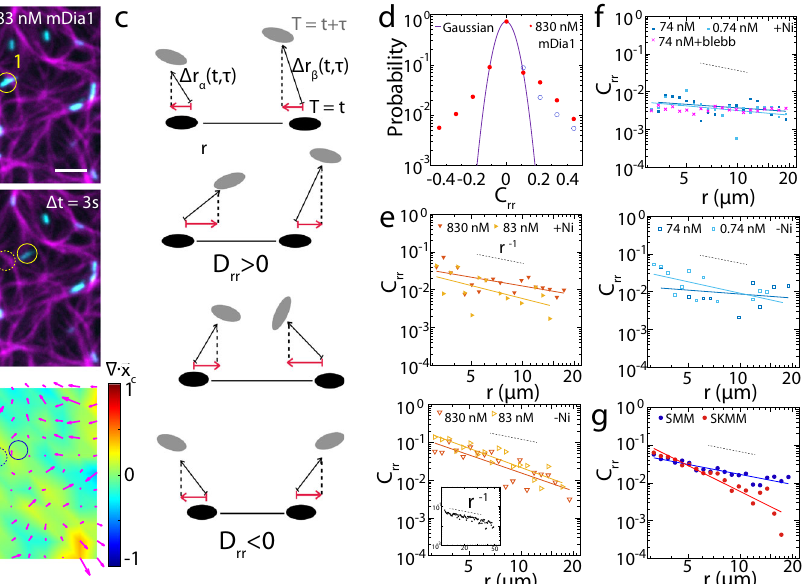
Fig. 4 | Branched F-actin attenuates the transmission of mechanical strain. a F-actin (magenta), Myosin II (cyan) and b strain heatmap and local actin velocity quiver plot (magenta) for 83nM mDia1. Scale bar = 10 μ m. c Diagrammatic illus- trationofTPConMyosinIIthick fi laments. d Probabilitydensitydistributionfor C rr of myosin thick fi laments in 830nM mDia1-nucleated F-actin network at r = 3 μ m between − 0.5and0.5(red)withGaussian fi t(purple).Bluedashedcirclesarepoints mirroring from left half of the plot showing asymmetryfor C rr . e and f show C rr for